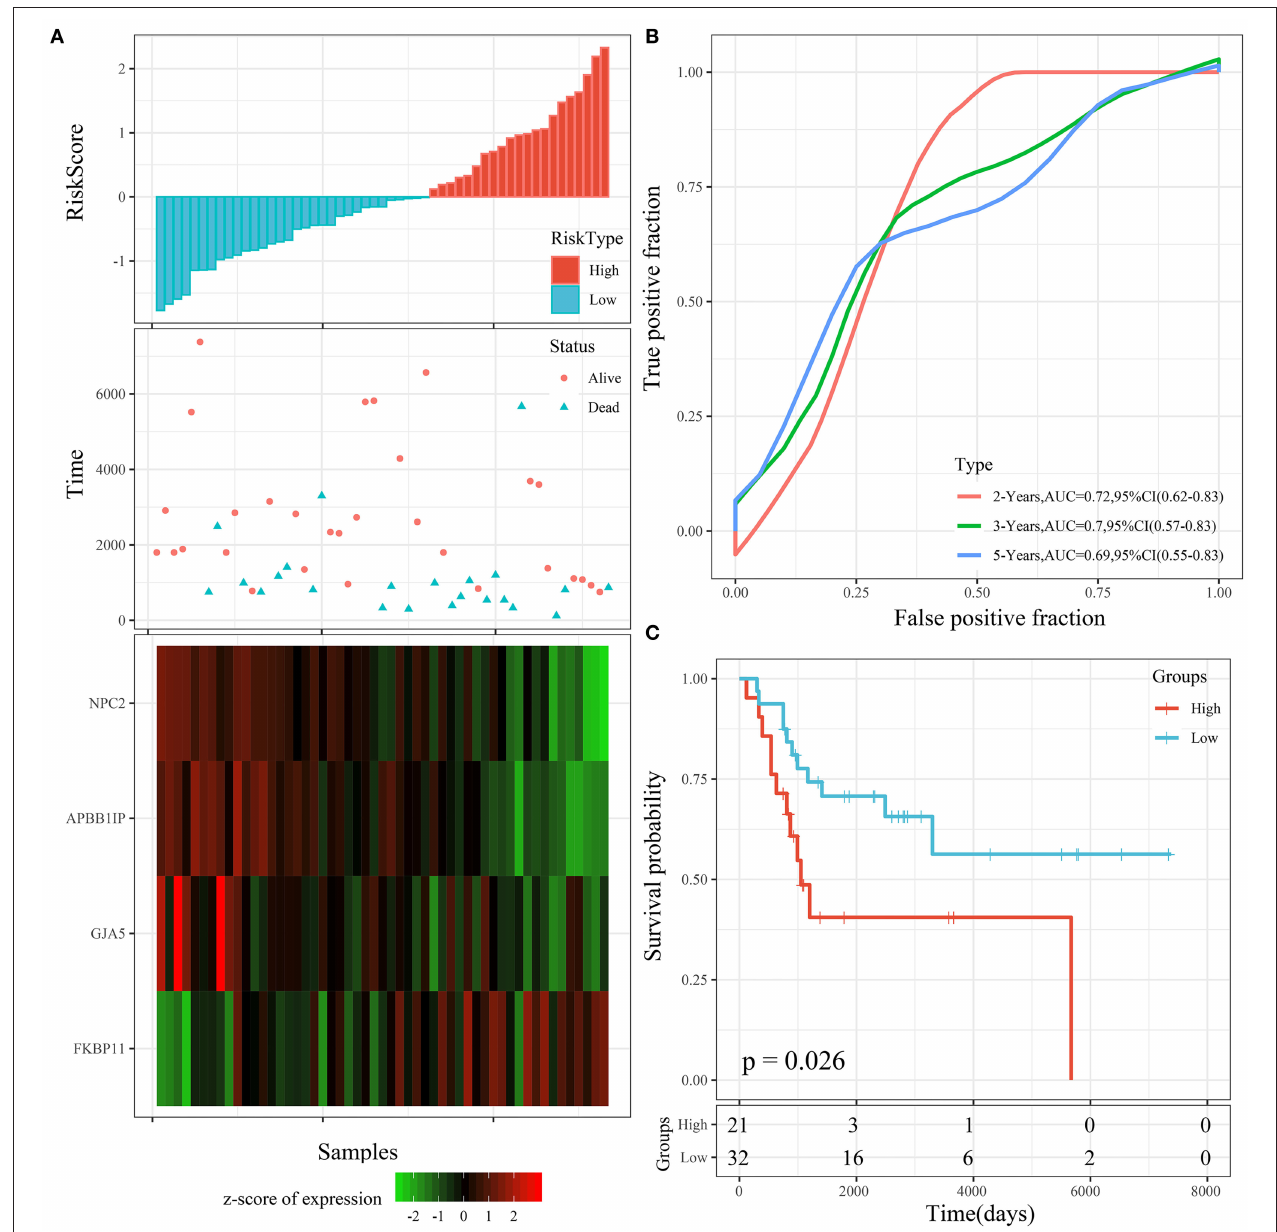
FIGURE 9 | (A) Risk score, survival time, survival status, and 4-gene expression in the GSE21257 testing cohort. (B) ROC curve and AUC of the 4-gene signature. (C) KM survival curve distribution of the 4-gene signature in the GSE21257 testing